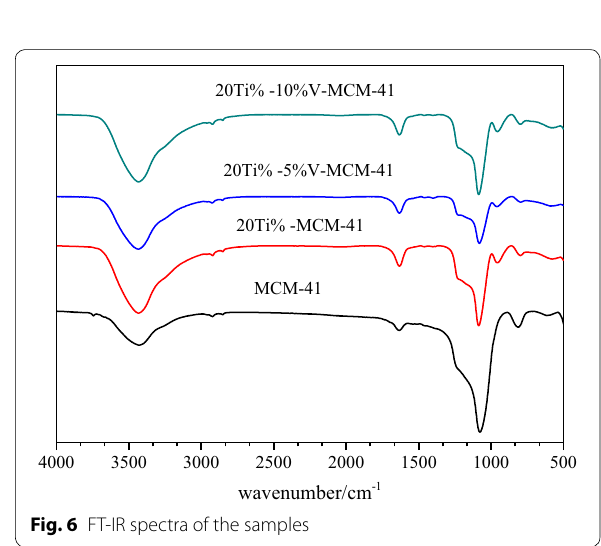
Fig. 6 FT-IR spectra of the samples